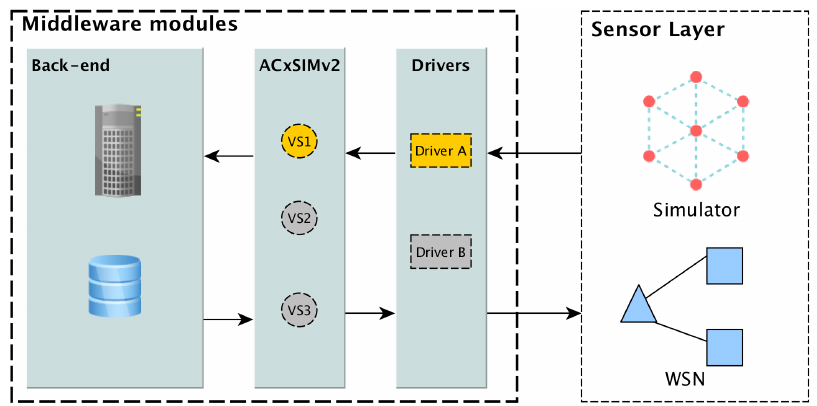
Figure 8. Middleware modularized